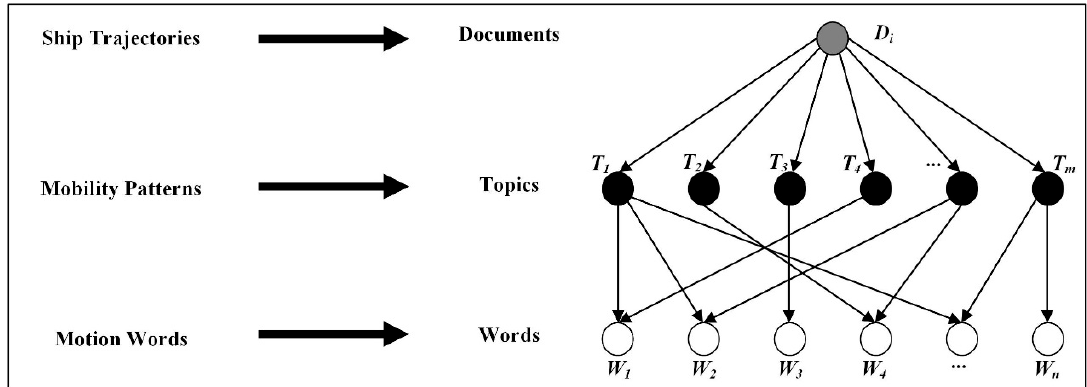
Figure 4. Analogy from trajectory-patterns discovering to document-topics learning [31].